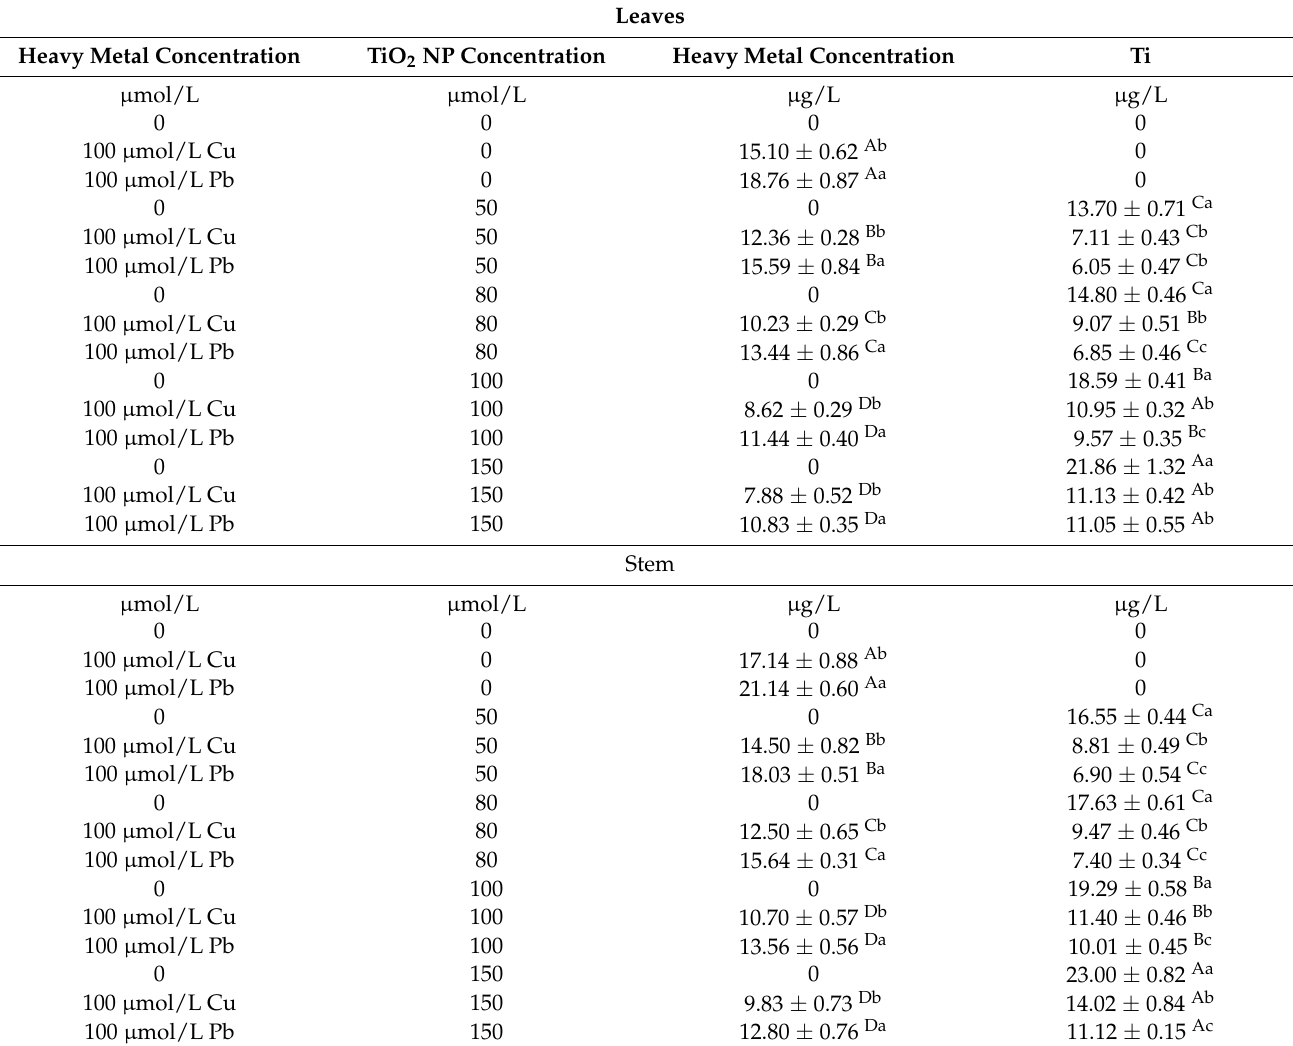
Table 3. Levels of accumulation of various concentrations of TiO 2 NPs and heavy metal (Cu, Pb) contents in bamboo leaves, stems, and roots. The capital letters show statistically significant differences across different concentrations of TiO 2 NPs alone or in com-bination with 100 µ M Cu and 100 µ M Pb, while the lowercase letters show statistically significant differences within each concentration of TiO 2 NPs alone and in combination with 100 µ M Cu and 100 µ M Pb, according